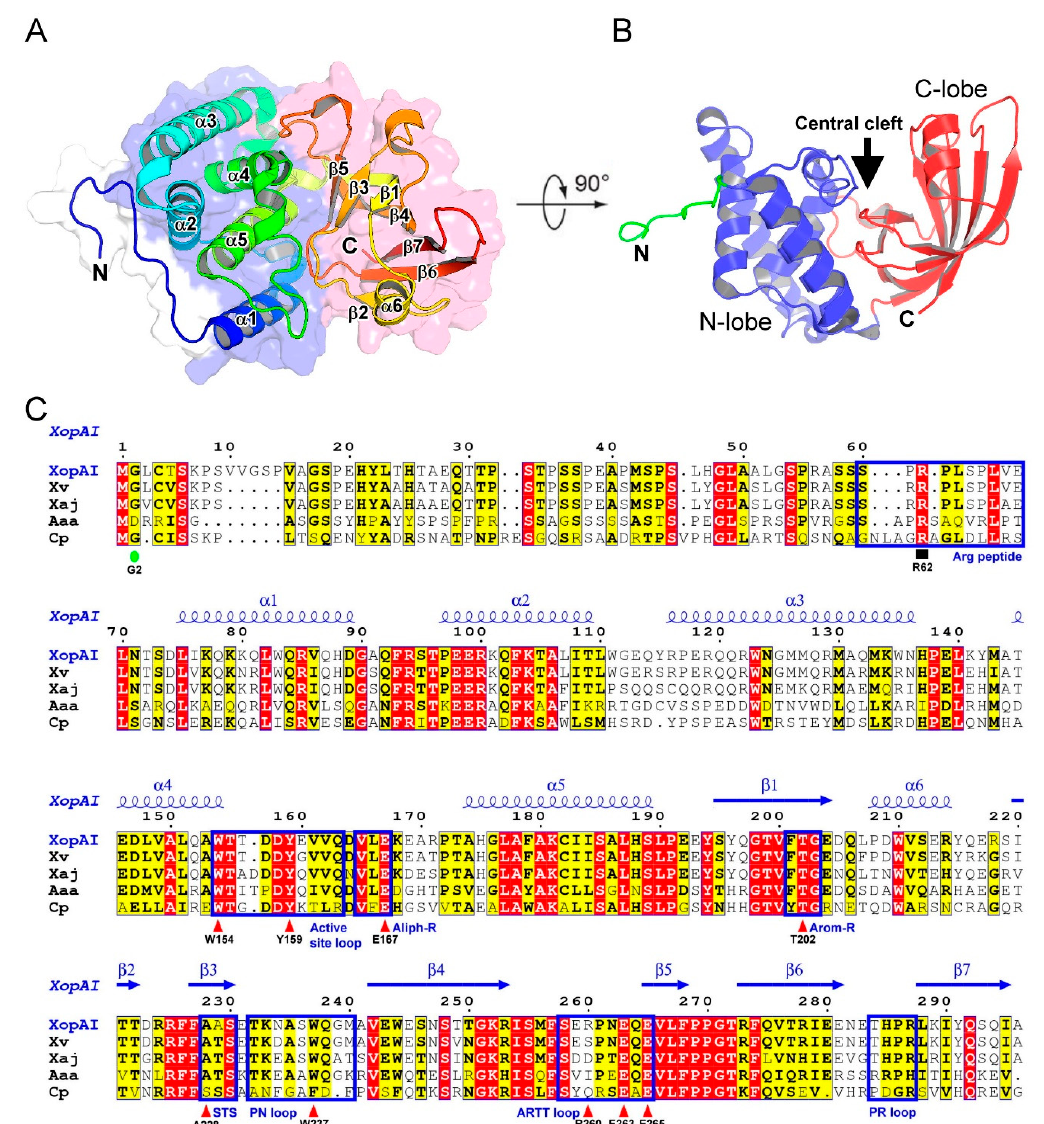
Figure 1. Crystal structure of XopAI and protein alignment with its homologs. ( A ) The ribbon model that shows the structure of XopAI spanning residues 60 to 296. It is colored in the rainbow scheme (from N- to C-terminus, from blue to red), and its secondary structural elements are labeled. Regions that belong to the N- and C-lobes are contoured in blue and red shadows, respectively, while the N-terminal disordered region is in white. ( B ) A view rotated by 90° relative to (A) showing the central cleft formed between the N- and C-lobes (blue and red ribbons, respectively). The N-terminal disordered region is highlighted in green. The central cleft is indicated by an arrow. ( C ) The sequence alignment of XopAI homologs; we selected five representative sequences for this concise alignment, and a more comprehensive version with 17 sequences is shown in Figure S3. The conserved residues are shaded yellow and identical residues are shaded red. Secondary structure elements based on XopAI crystal structure determined in this study are displayed above the alignment. Blue boxes outline those important regions in XopAI. Key residues in the central cleft are marked with red triangles and labeled according to XopAI sequence. A green oval shows the putative myristoylation site, and a black square indicates the crucial Arg in the Arg peptide. The following bacteria strains were analyzed: XopAI ( Xanthomonas axonopodis pv. citri , GenBank accession no.: WP_011052119, this study), Xv ( X. vesicatoria strain LM159, CP018470), Xaj ( X. arboricola pv. juglandis strain Xaj 417, CP012251), Aaa ( A. avenae subsp. avenae , AVS84630), and Cp ( Collimonas pratensis ,